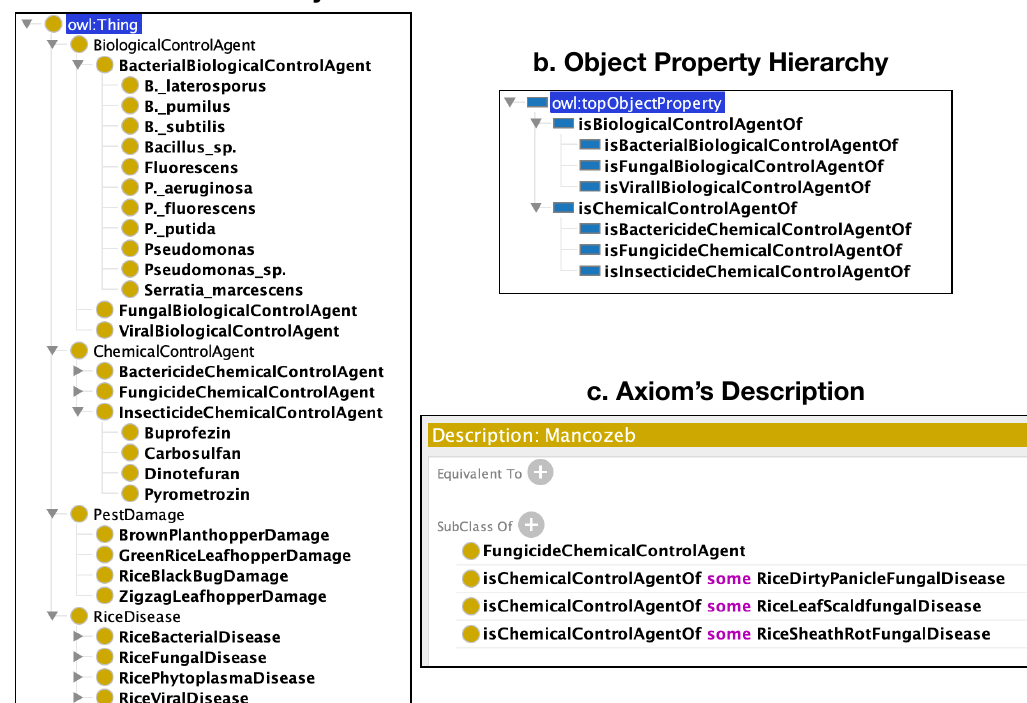
Figure 2. The structure of TreatO ontology is divided into three parts: ( a ) the class hierarchy of TreatO; ( b ) the object properties of TreatO; and ( c ) an example of axioms representing Mancozeb (a fungicide chemical control agent for various rice